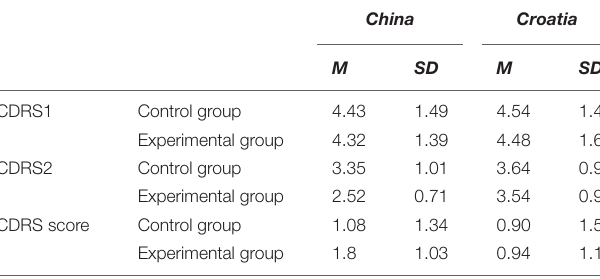
TABLE 7 | Descriptive Statistics for evaluation of body image size by condition and